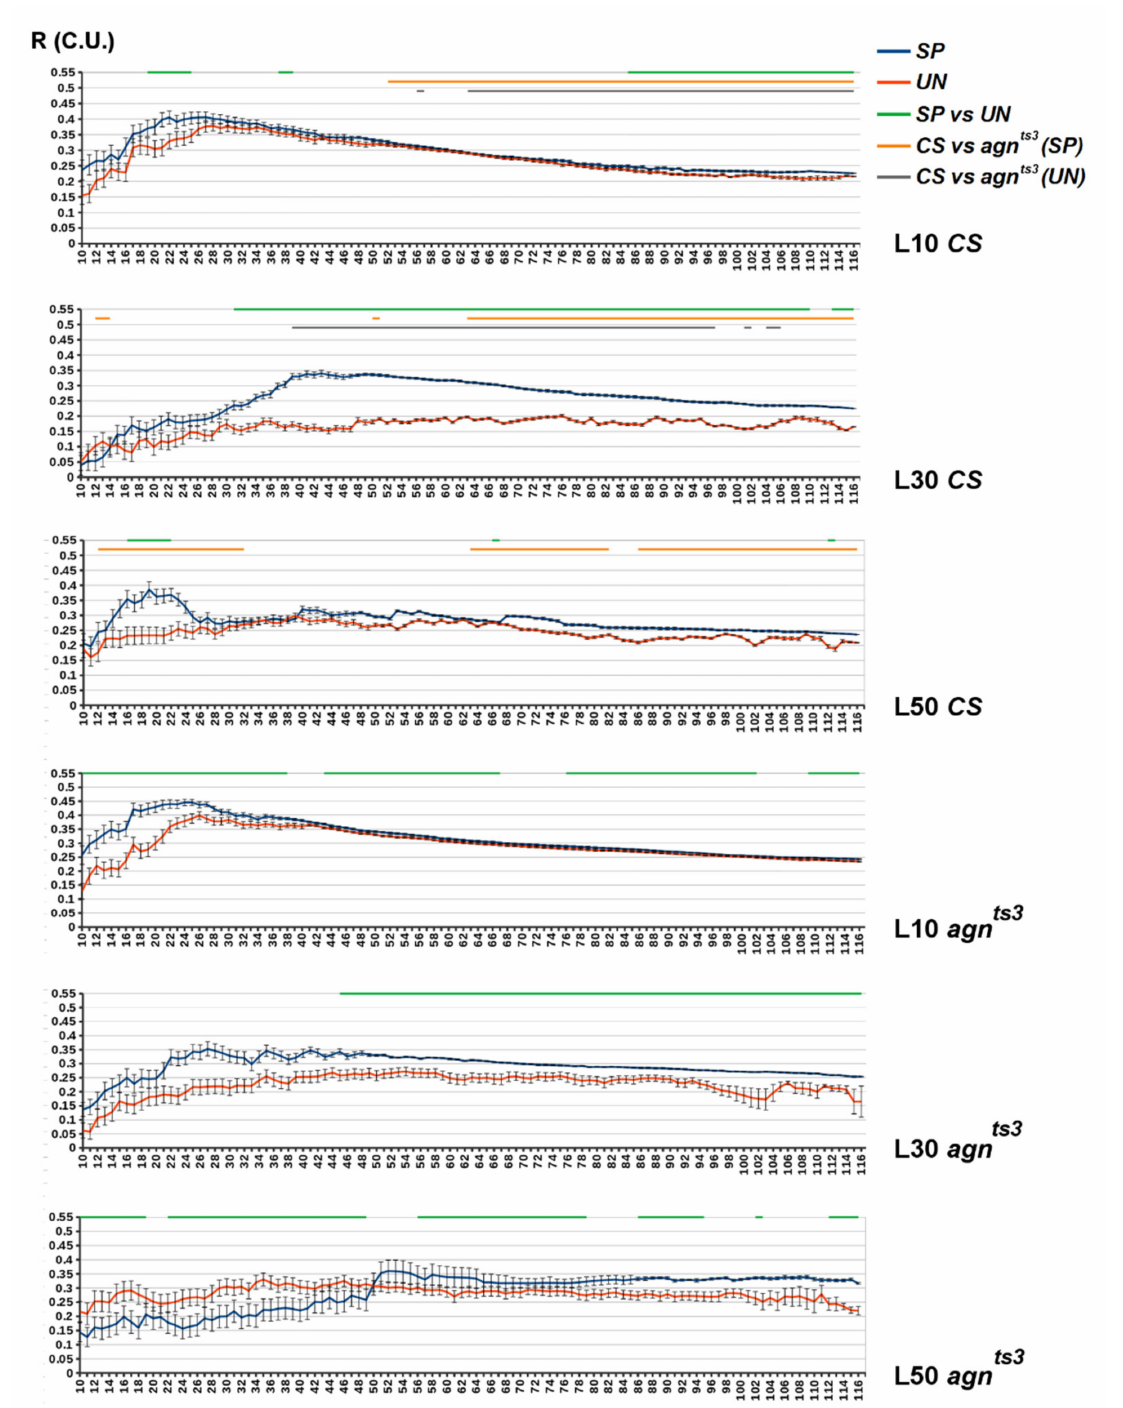
Figure 3. The average R values for the chromosomal zones of different intersection distances (D). X axis: D—zone length (in sections). Y axis: R (conventional units). Standard error of mean is shown. The areas of D with statistical differences are shown by straight lines above the diagram: green—SP vs. UN, orange—SP ( CS ) vs. SP ( agn ts3 ), grey—UN ( CS ) vs. UN ( agn ts3 ) (two-sided Mann–Whitney U-test; p < 0.05, n =